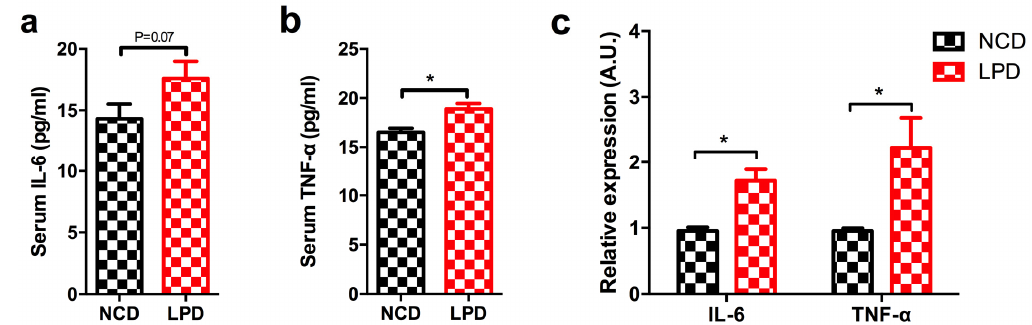
Figure 5. Effect of maternal LPD on serum IL ‐ 6 and TNF ‐α concentrations and mRNA expression in the offspring at weaning. ( a ) Serum IL ‐ 6; ( b ) serum TNF ‐α ; and ( c ) IL ‐ 6 and TNF ‐α mRNA expression in the livers of offspring. Data represented as the mean ± SEM ( n = 6 to 8, per group). * p < 0.05, vs. the NCD group. LPD, low ‐ protein diet; NCD, normal chow diet; IL ‐ 6: interleukin ‐ 6; TNF ‐α : tumor